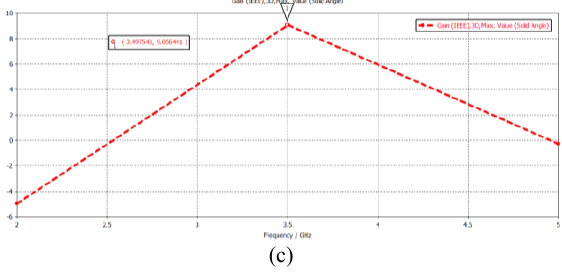
Fig. 5. (a) 1×4 antenna array, (b) reflection coefficient as a function of frequency, (c) gain as a function of frequency